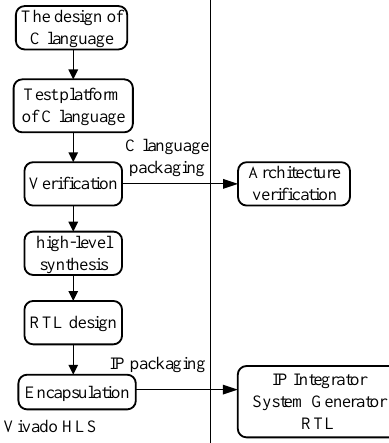
Figure 11. Vivado High-Level Synthesis (VHLS) development process.